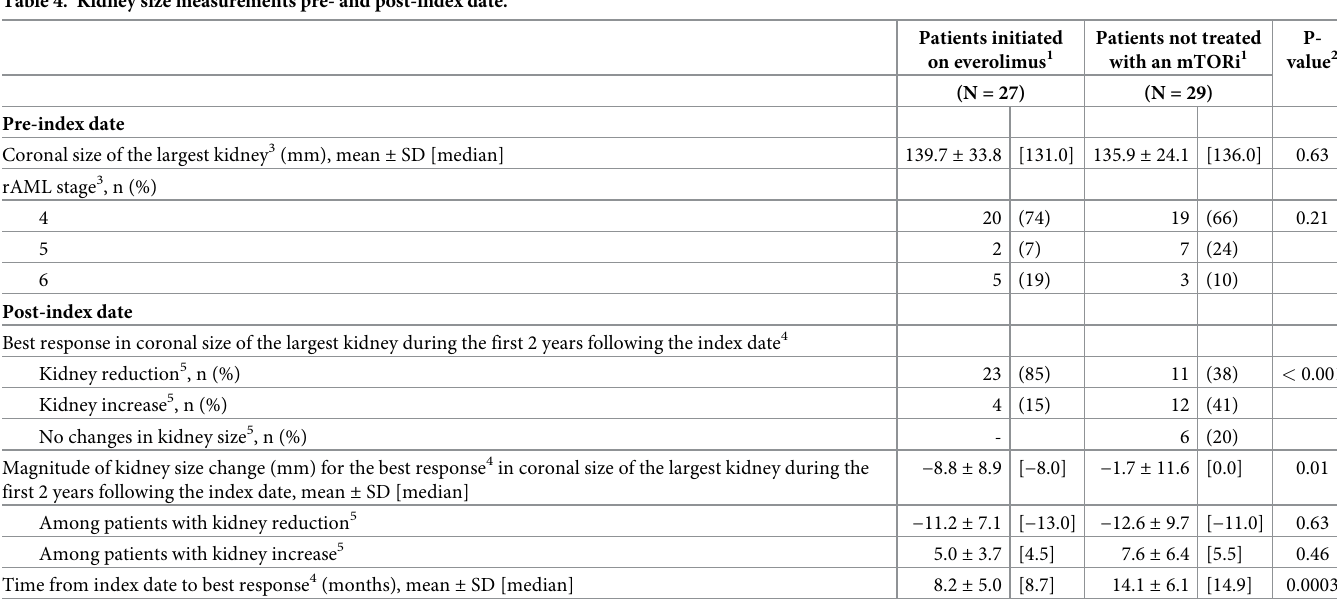
Table 4. Kidney size measurements pre- and post-index